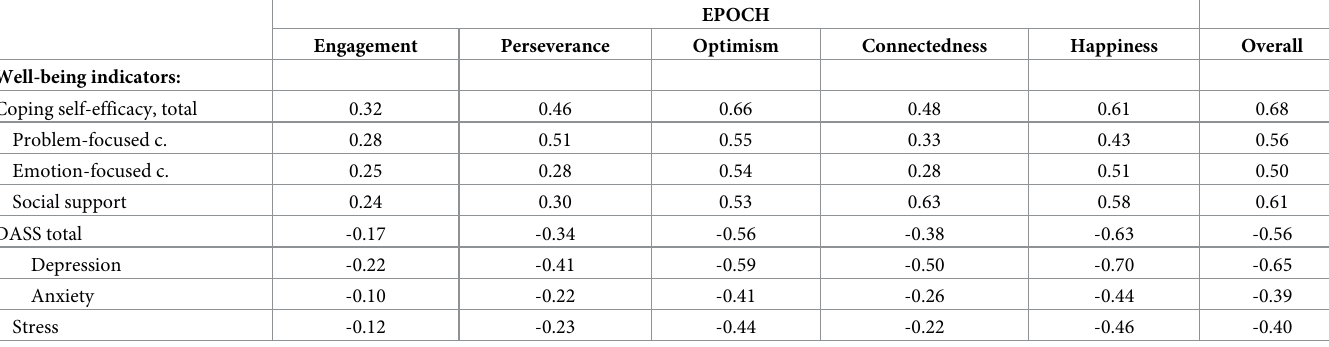
Table 4. Intercorrelations between the EPOCH subscales with well-being indicators ( N =